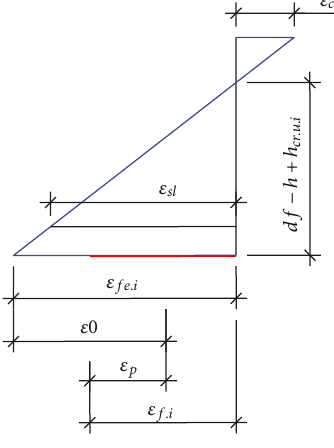
Figure 5: Limit state of strain in the fl exural